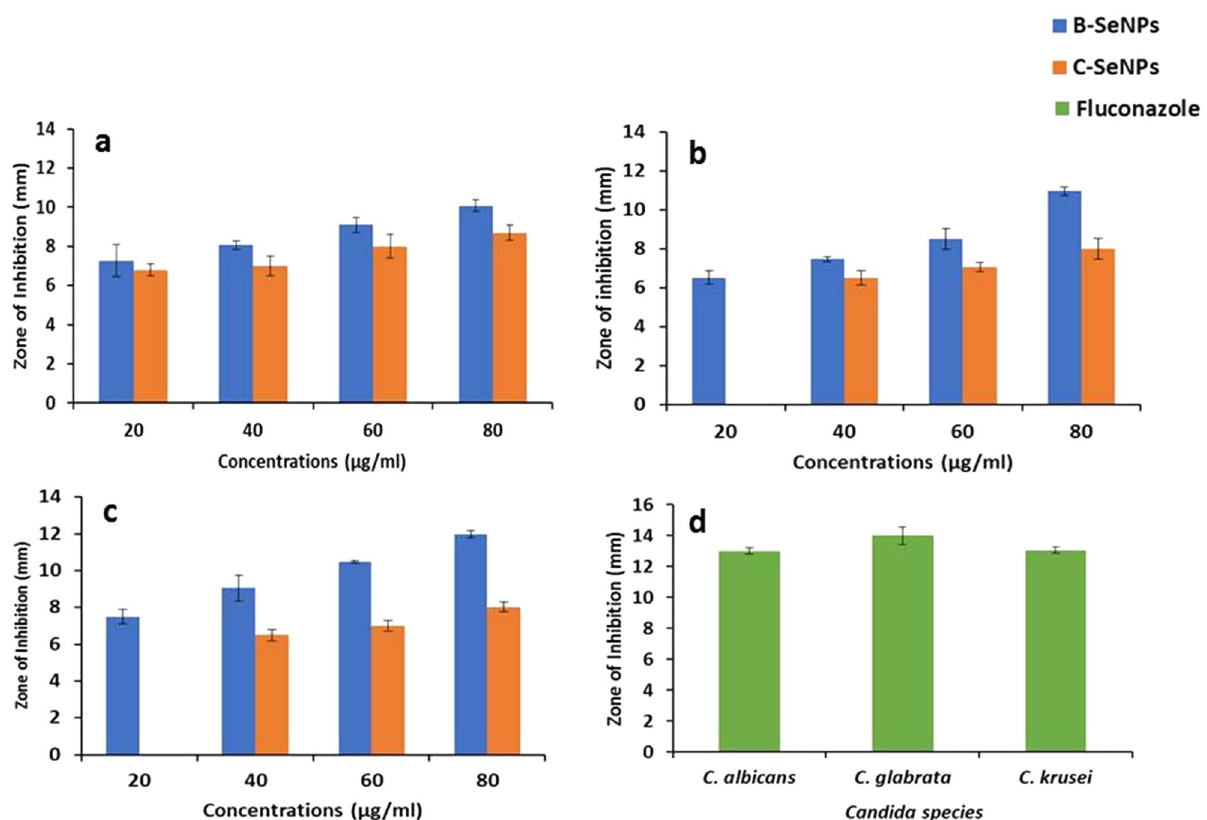
Figure 7. Comparative anti-fungal activity of B - SeNPs and C-SeNPs by disc diffusion assay. ( a ) C. albicans ( b ) C. glabrata ( c ) C. krusei ( d ) Fluconazole.